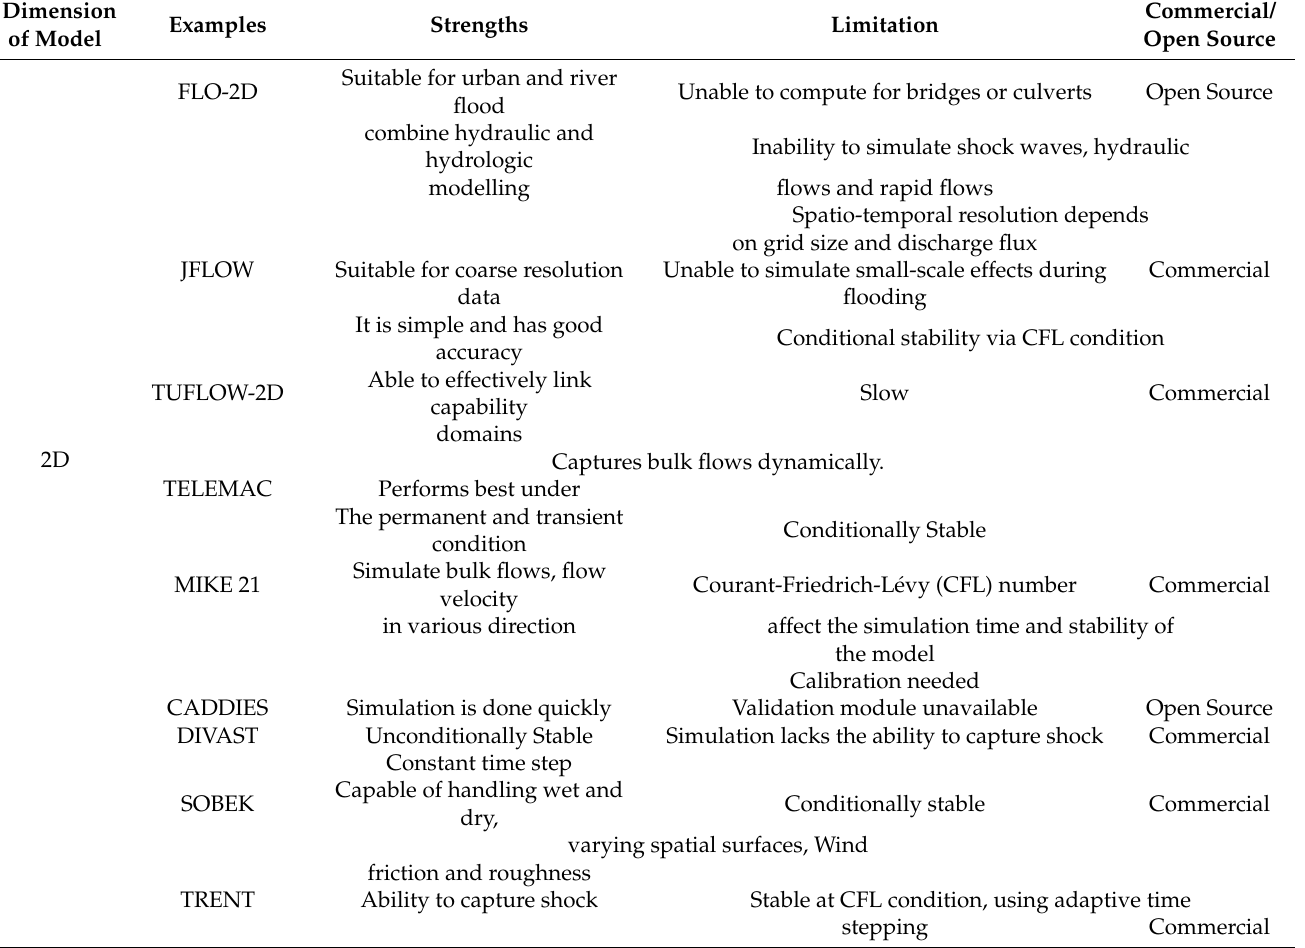
Table A2. Summary of the two-dimensional (2D) numerical tool in flood